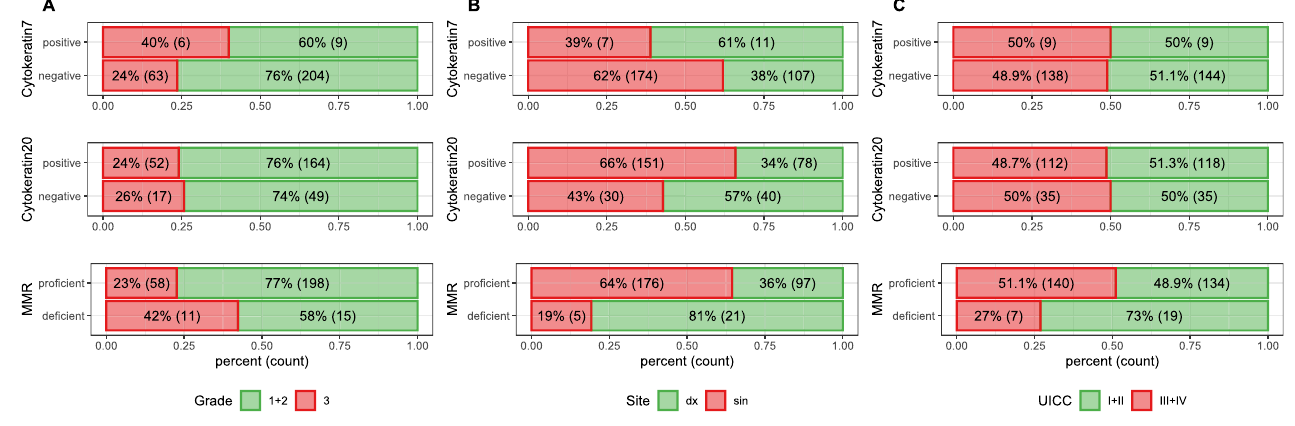
Figure 3. Bar chart from univariate logistic regression showing a ratio of low/high grade ( A ), right/left sided tumors ( B ) and I + II/III + IV UICC stage cases ( C ) among CK7 ± , CK20 ± and MMR-proficient/deficient CRCs. CK7 + CRCs are insignificantly more high-grade and right-sided. CK20 + CRCs are significantly more left-sided. MMR deficient CRCs are significantly more frequently high-grade, right-sided and